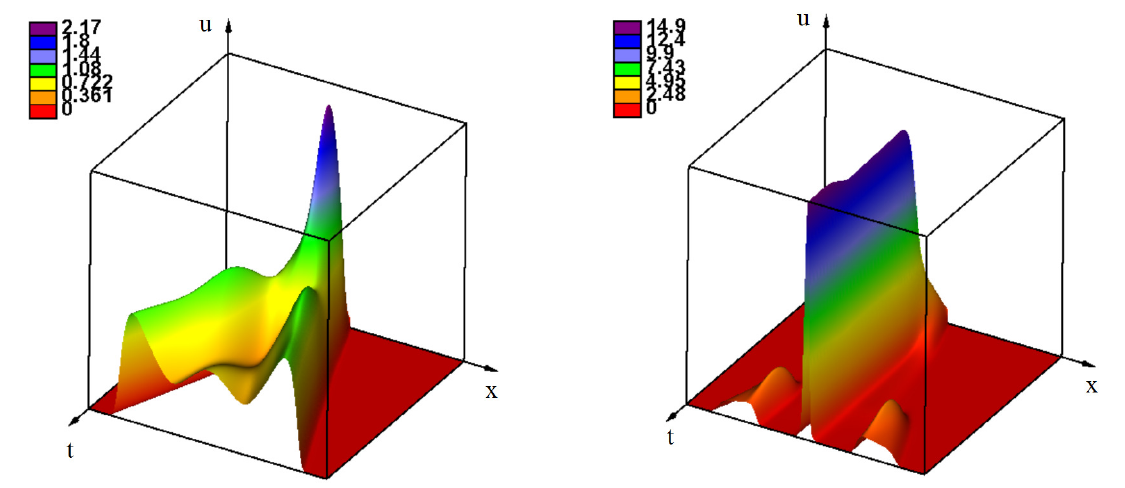
Figure 7. Numerical simulations of Equation (1) with two different initial conditions and the same values of parameters: D = 10 − 5 , r = 1, q = 1, N = 0.2, τ = 0, f ( u ) = k 1 e − k 3 u , k 1 = 1, k 3 = 0.6, the maximum of the initial condition equals 0.1 ( left ) and 0.9 ( right ), x 1 = 0.48, x 2 = 0.52, t =